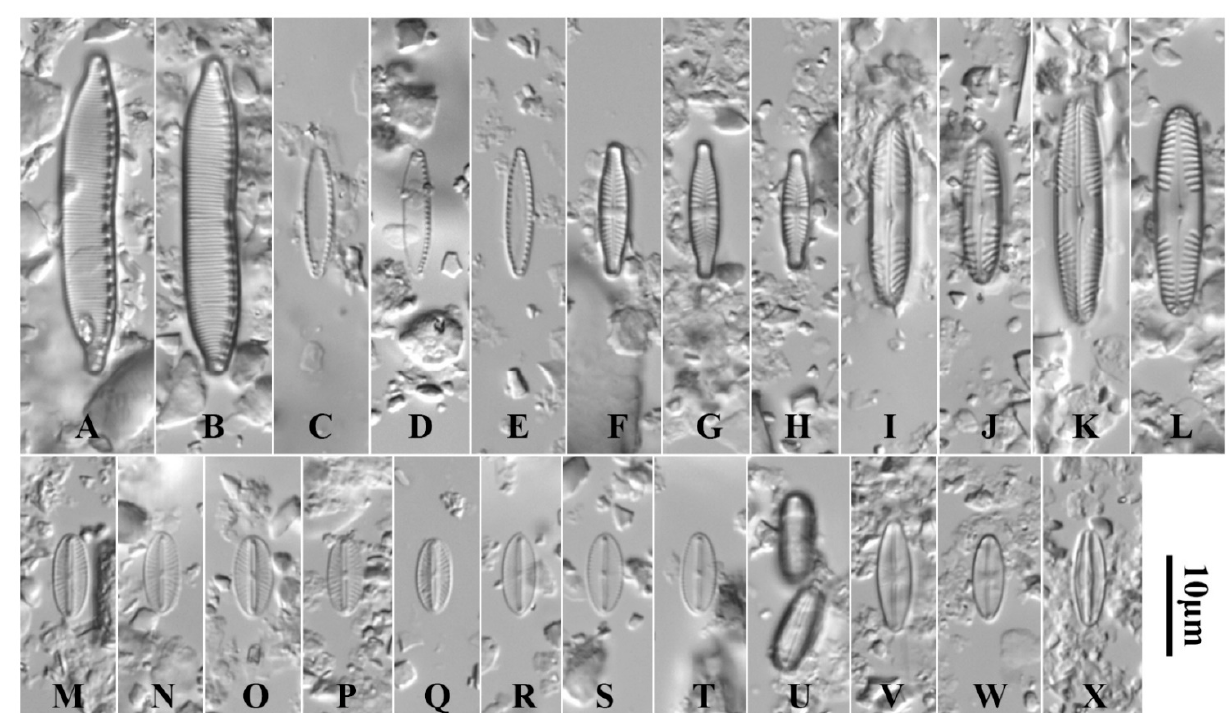
Figure 4. Dominant and some selected diatom taxa observed during the study: ( A , B ) Hantzschia amphioxys (Ehrenberg) Grunow; ( C – E ) Nitzschia pusilla Grunow; ( F – H ) Stauroneis thermicola (J.B. Petersen) J.W.G. Lund; ( I , J ) Pinnularia obscura Krasske; ( K , L ) Pinnularia schoenfelderi Krammer; ( M – Q ) Mayamaea atomus (Kützing) Lange-Bertalot; ( R – T ) Mayamaea permitis (Hustedt) K. Bruder and Medlin; ( U ) resting form of unidentified Mayamaea sp.; ( V , W ) Sellaphora nana (Hustedt) Lange-Bertalot, Cavacini, Tagliaventi and Alfinito; X- Microcostatus aerophilus Stanek-Tarkowska, Noga, C.E. Wetzel and Ector.